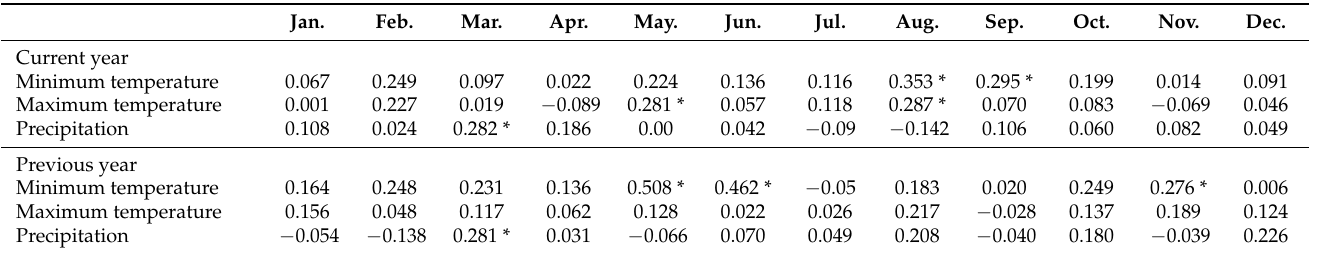
Table 4. Correlation coefficients between the number of the Pinus sibirica seedlings in the mountain tundra and air temperature and precipitation.